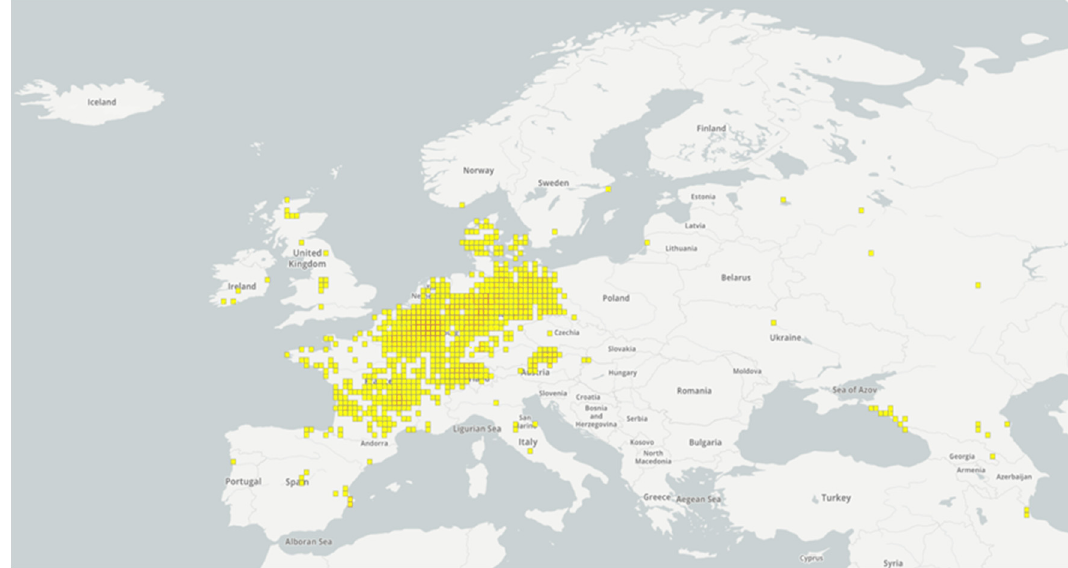
Figure 2. Occurrence of the raccoon in Europe. Detection of animals from 2000 to 2022 (yellow dots). Analysis and visualization of d“Procyon lotor (Linnaeus, 1758)” using the Global Biodiversity Information Facility (GBIF) in November 2022 (https://www.gbif.org/species/5218786; accessed on 18 November 2022). Basis of records: observation, machine observation, human observation, material sample, material citation, and preserved specimen.